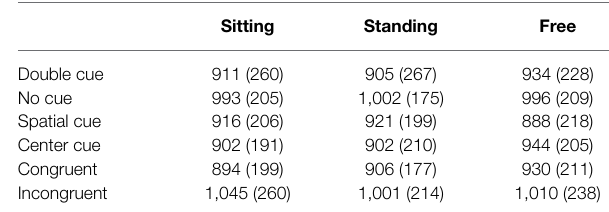
TABLE 2 | Mean of median reaction time (in ms) for different cue and target conditions in each body mobility condition. Sitting Standing